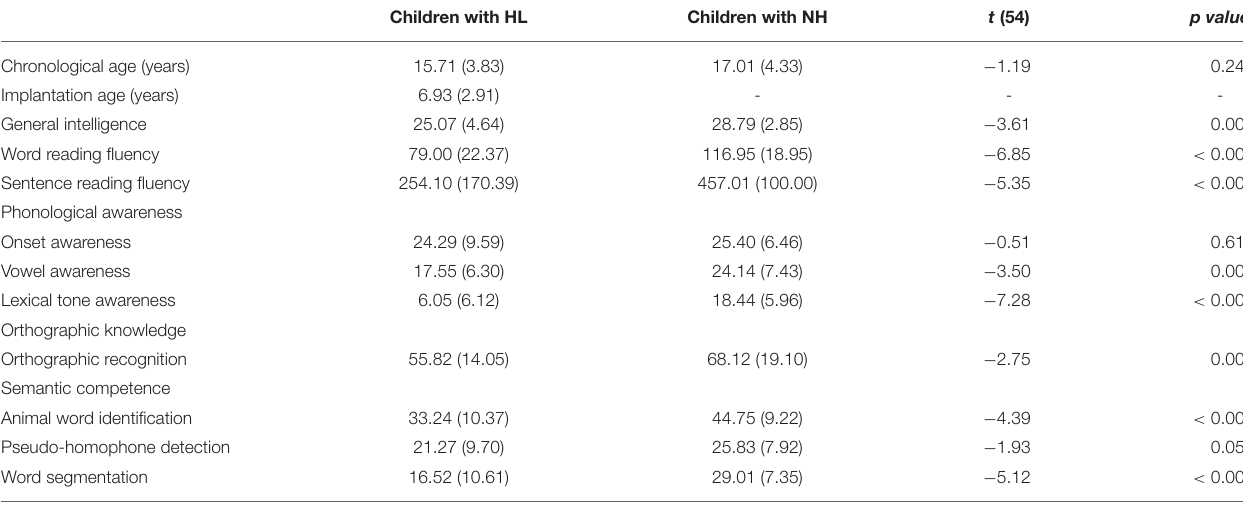
TABLE 1 | Descriptive statistics and group comparisons on all the measures (mean ± SD) for the children with HL and NH. Children with HL Children with NH